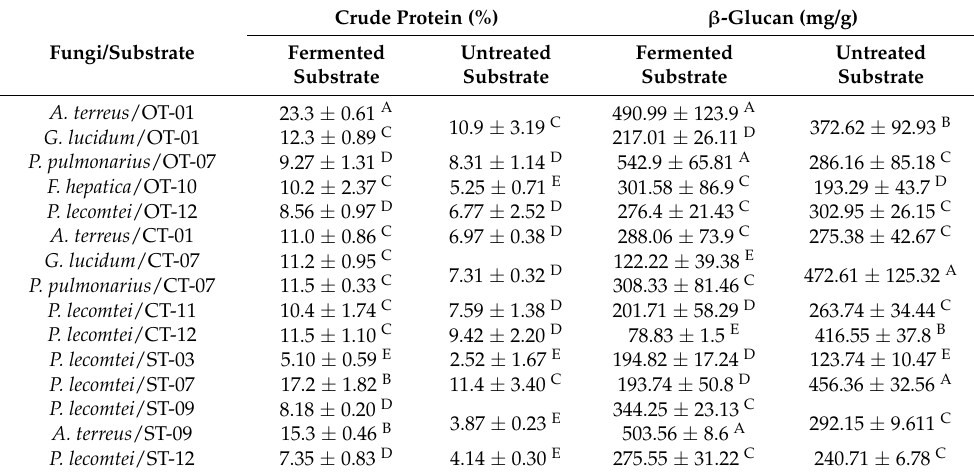
Table 4. Total crude protein and β -glucan content in the filamentous fungi fermented and untreated substrates commonly used as animal feed